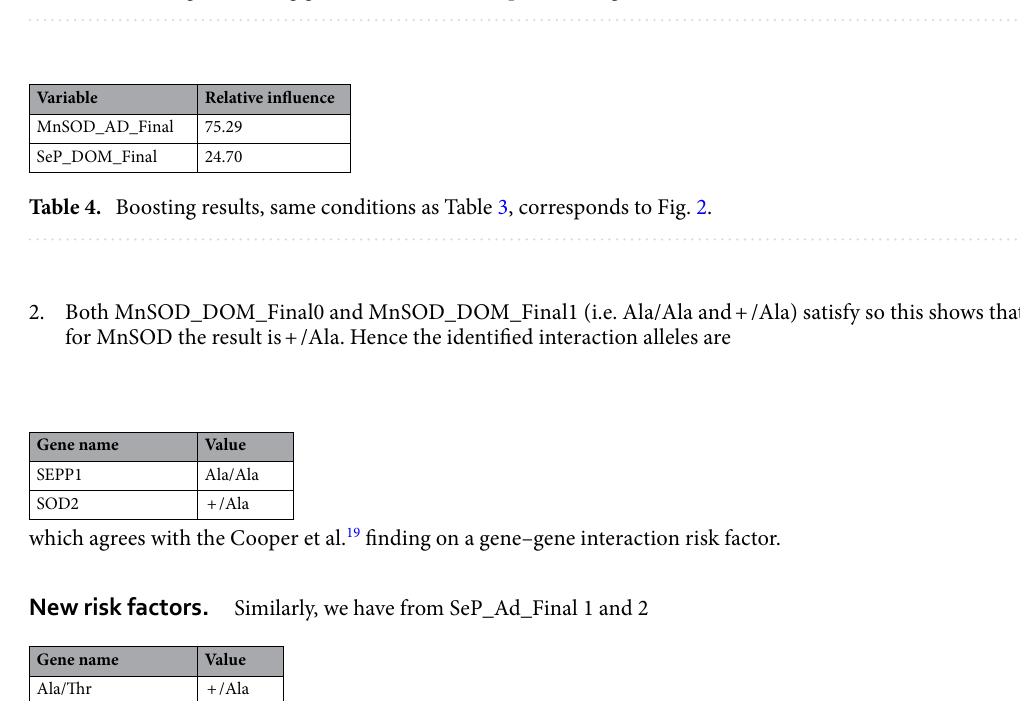
Table 3. Boosting results Pkg gbm Ada Boost, corresponds to Fig. 1.